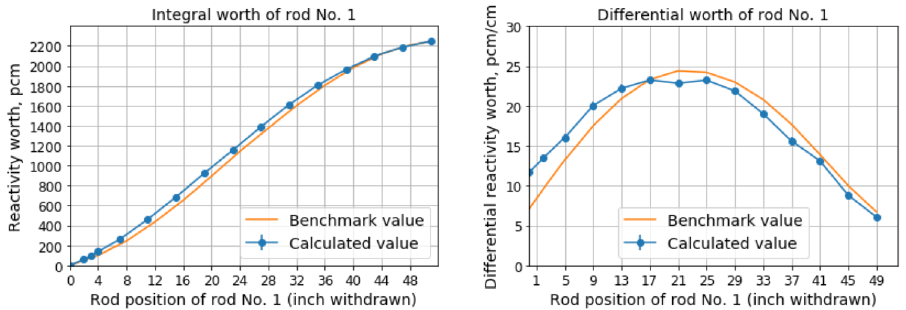
Figure 7. Integral Worth (Left) and Differential Worth (Right) of Rod No.